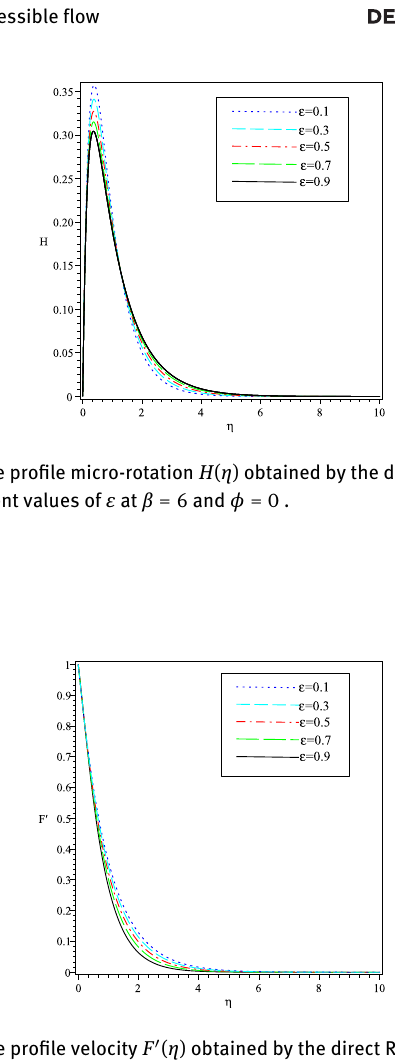
Fig. 4: The profile velocity F (cid:48) ( η ) obtained by the direct RBFs for different values of ε at β = 6 and ϕ = 0 .